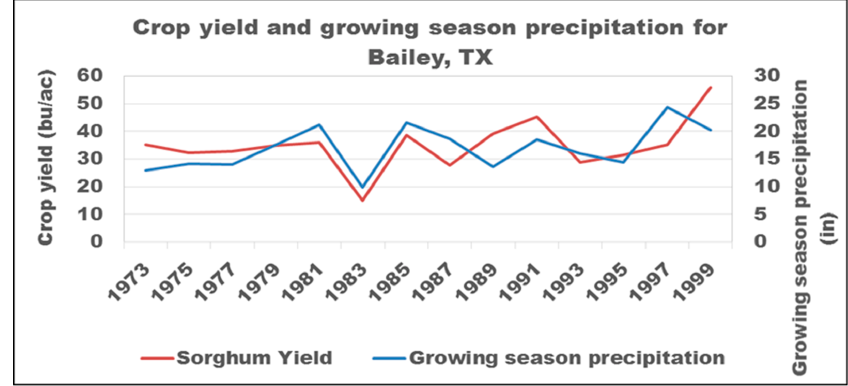
Figure 7. Example for crop yield trends closely following growing season total precipitation.